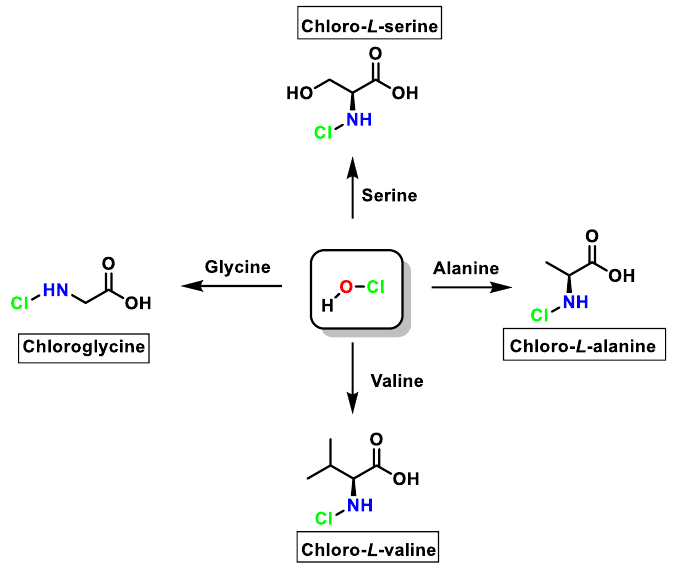
Figure 21. Schematic the mechanism of formation of N -chloro- α -amino acids from amino acids includes an electrophilic attack via the Cl + of HOCl on the nitrogen atom together with a proton transfer from the nitrogen atom to HOCl to release a water molecule.